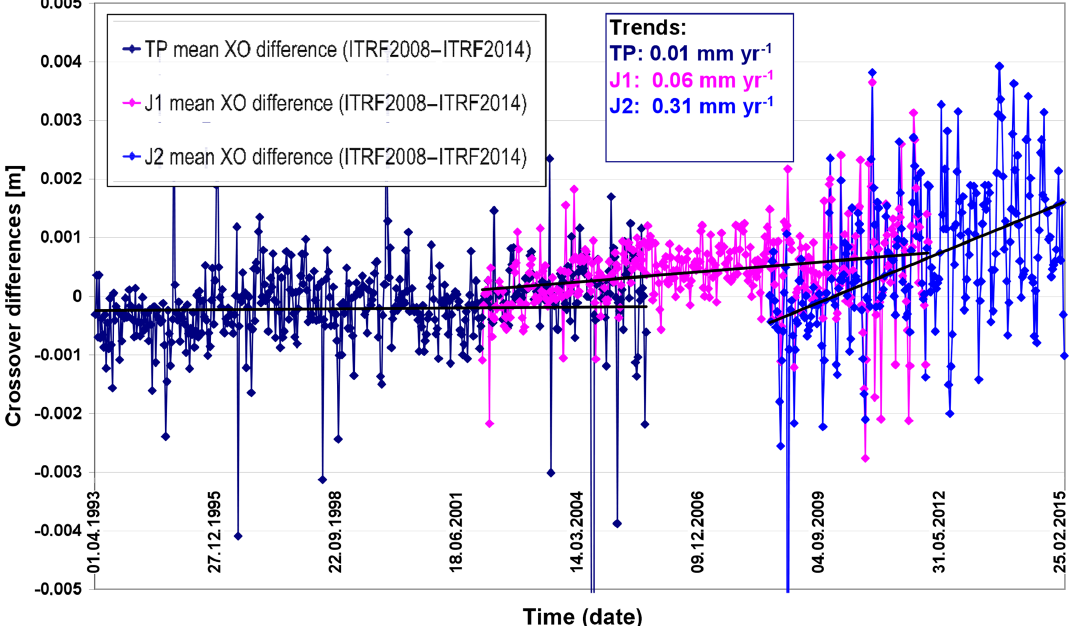
Figure 3. Differences of the crossover (XO) differences for the TOPEX (TP), Jason-1 (J1), and Jason-2 (J2) missions between VER11 and VER13 orbits. Values are in meters. The x axis shows time from 1 April 1993 to 25 February 2015.